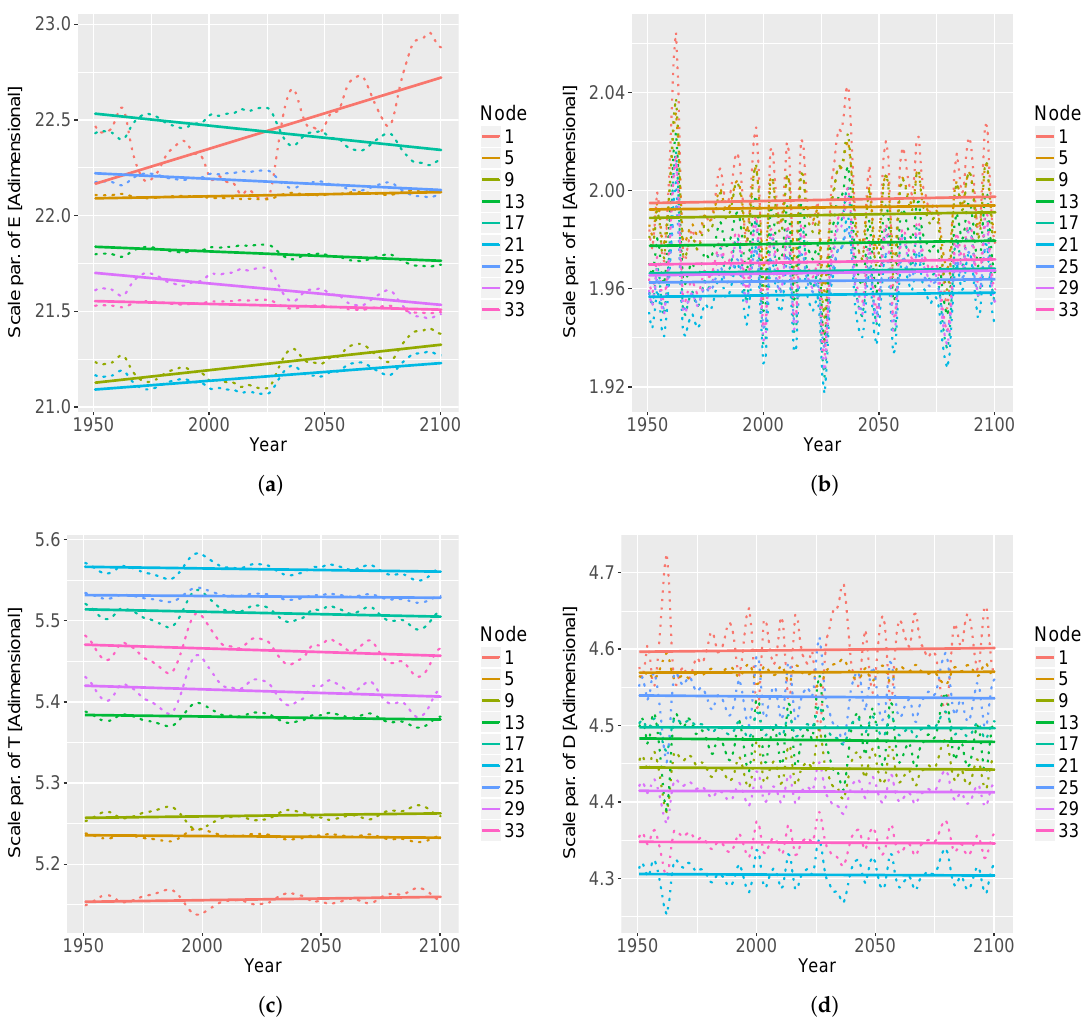
Figure 8. Scale parameter β of the GPD that models ( a ) E , ( b ) H p , ( c ) T p , and ( d ) D at selected nodes, under the RCP8.5 scenario. The SC was used in the VGAM to predict the scale parameter β of H p . The EA was used in the VGAM to predict the scale parameter β T p . The first time-derivative of SC was used in the VGAM to predict the scale parameter β of D . The scale parameter β of E is not affected by the selected climate indices. The time series are approximated by a straight line, which helps to see the trend of the scale parameter β at each